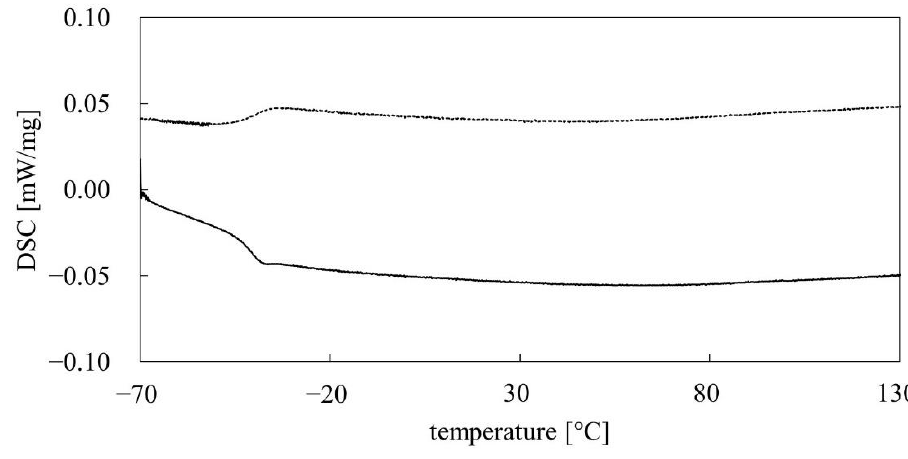
Figure 8. DSC thermograms of PMFOS (cooling curve—dotted line; heating curve—solid line). Based on the performed DSC analysis, the glass transition temperature T g of the PMFOS material was determined. The T g determined for the heating and cooling of the sample have convergent values of − 44.0 and − 44.3 °C, respectively. A DSC analysis of the initial PMHS was also performed. In this case, no phase transitions in the temperature